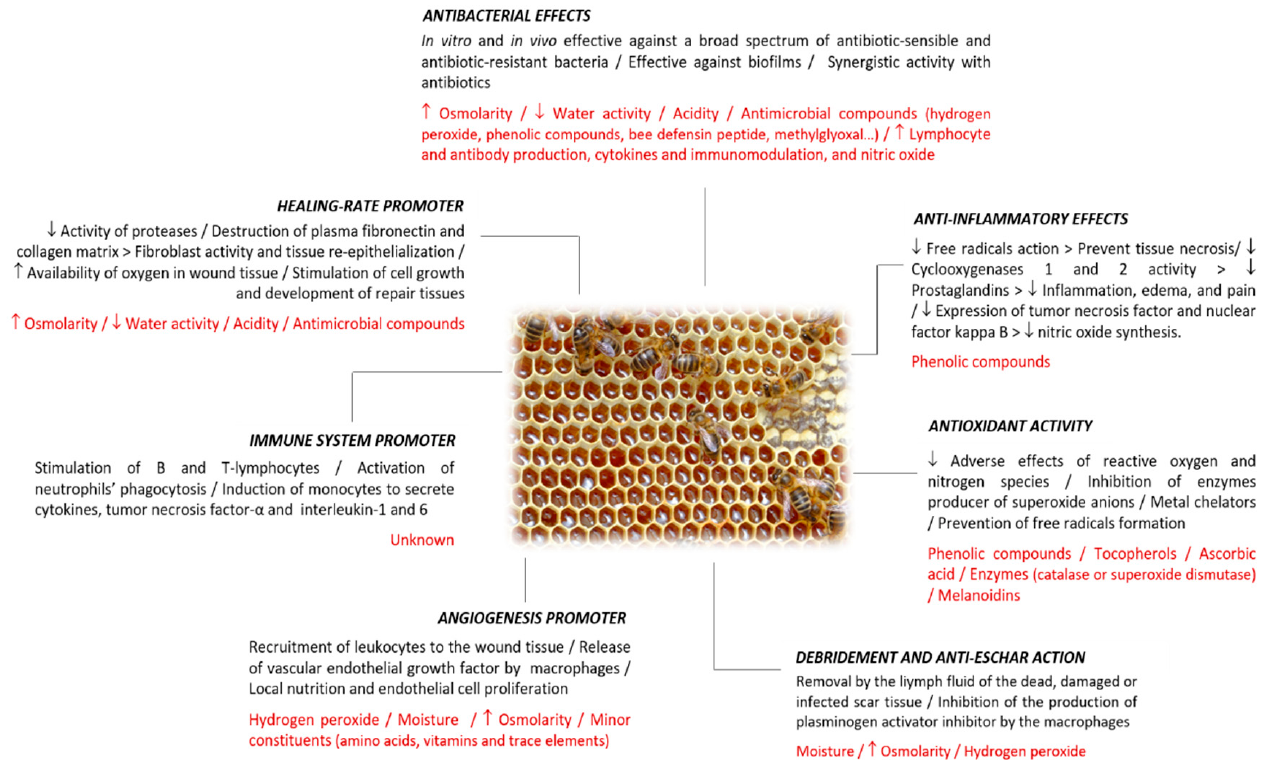
Figure 2. Wound healing mechanisms described for honey, different effects related to each mechanism, and the compound(s) or honey characteristics associated with the mechanism.